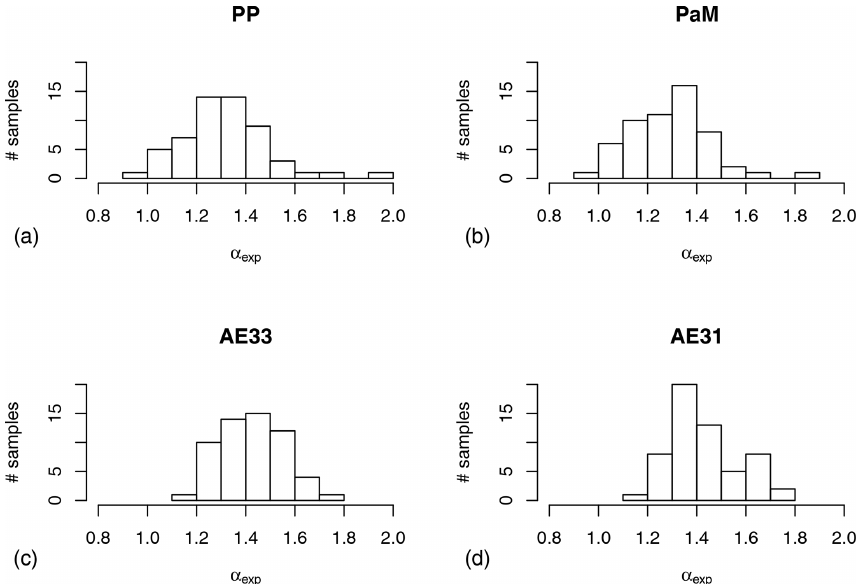
Figure 4. Frequency distribution in terms of the number (#) of samples of the experimental absorption Ångström exponent ( α exp ) calculated using Eq. (6) for the different instruments. PP (a) and PaM (b) are calculated from four-wavelength b abs (λ) information in the range of 405–780nm, whereas AE33 (c) and AE31 (d) results are calculated from seven-wavelength b abs (λ) obtained using C AE31_0 and C AE33_0 in the range of